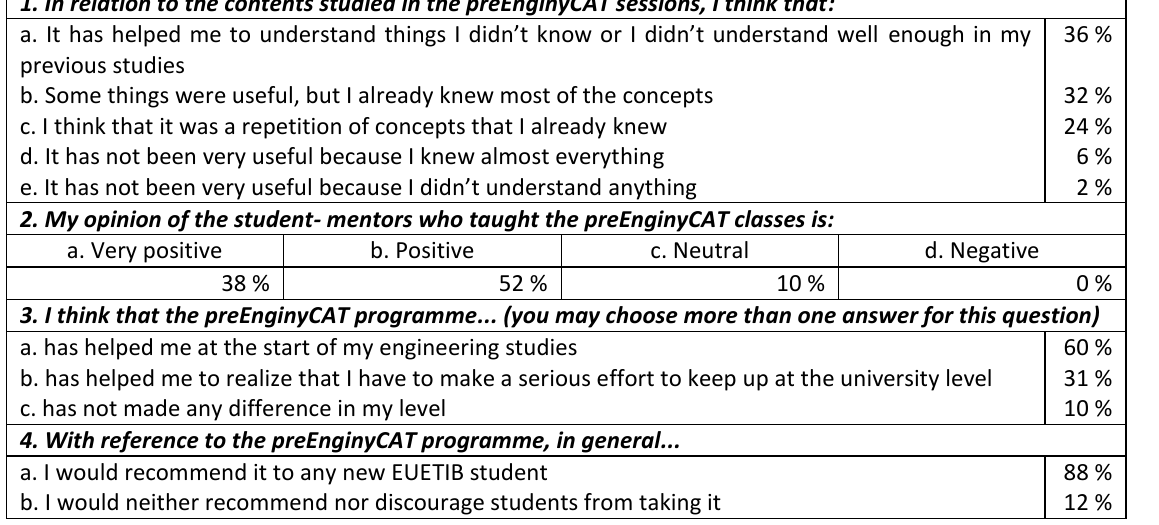
Table 3. Results of the final evaluation